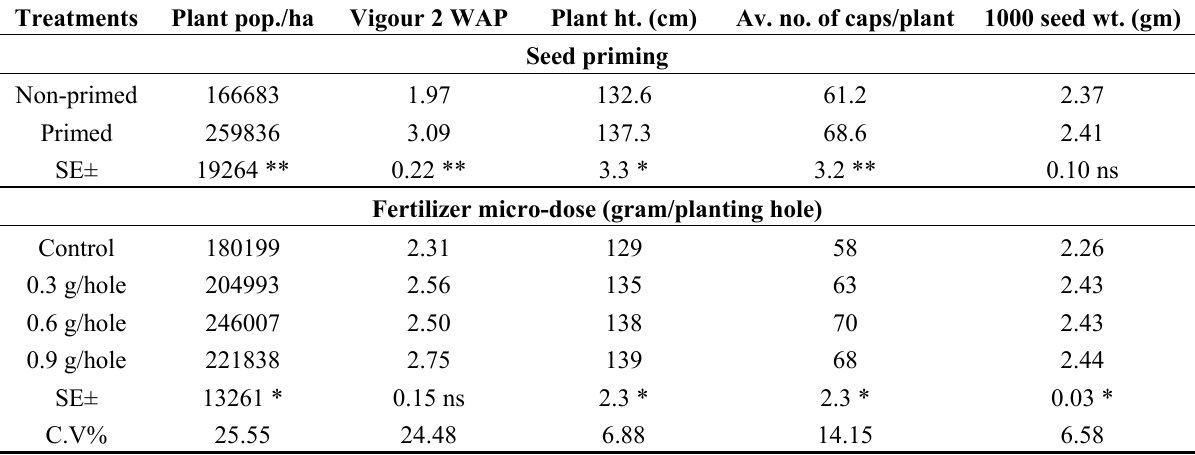
Table 6. Effect of seed priming and micro-dosing of fertilizers on sesame combined across two seasons.